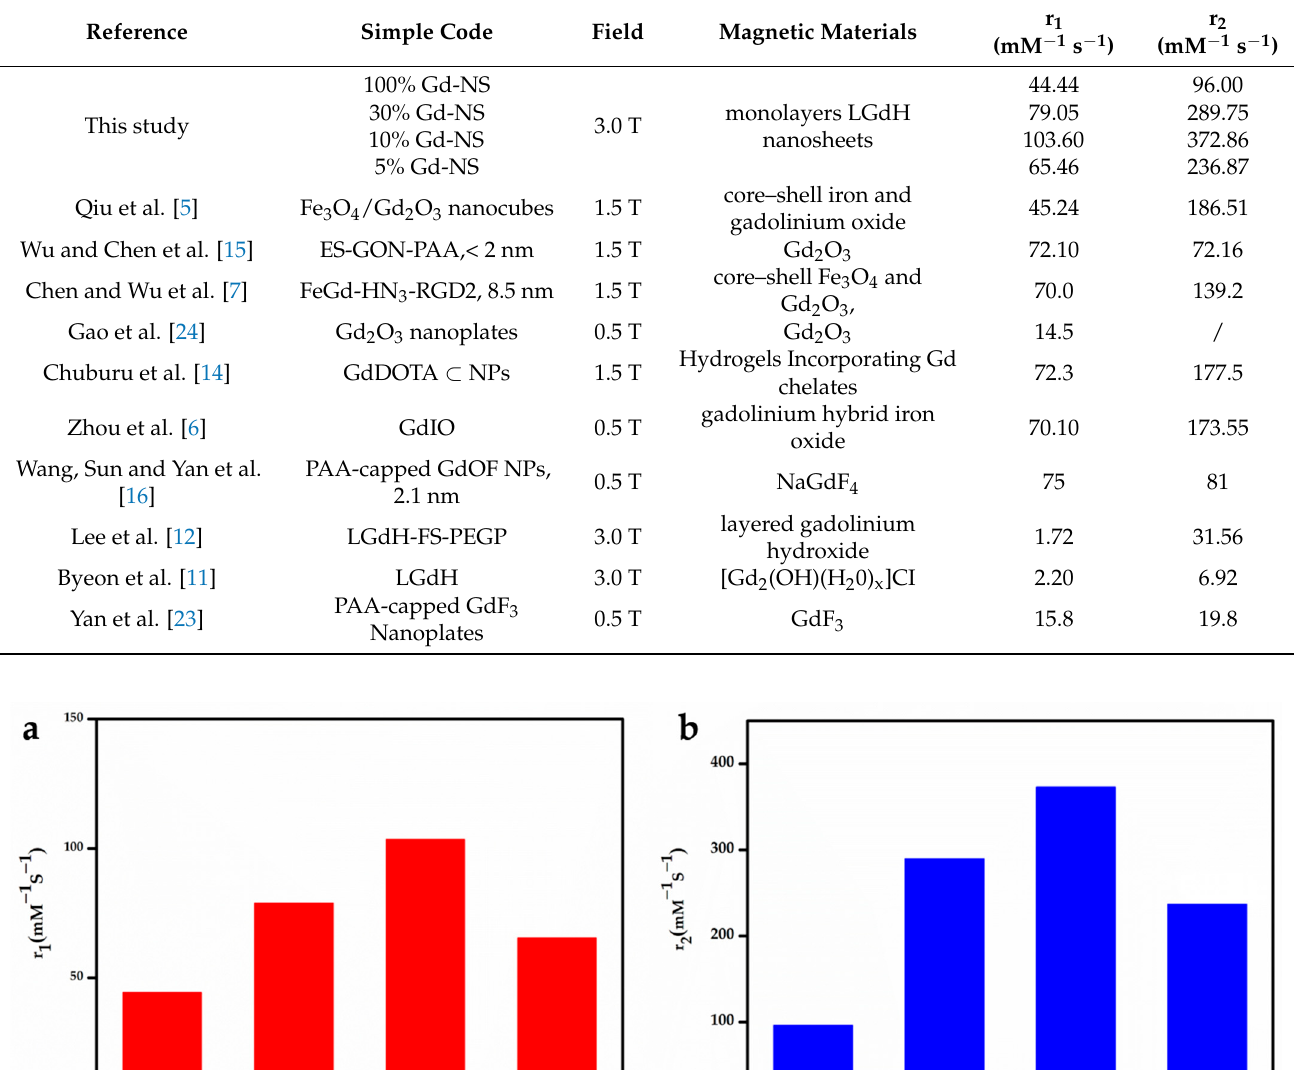
Table 1. Summary of magnetite nanoparticles for r 1 and r 2 relaxivity.